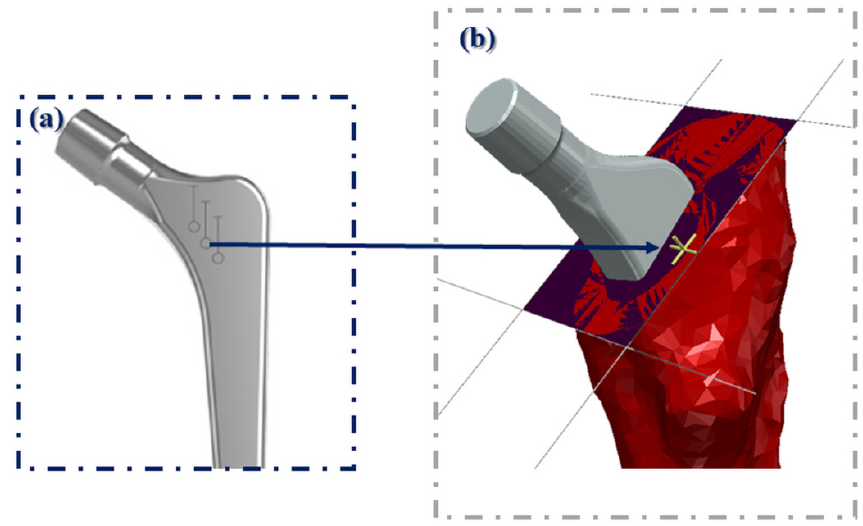
Figure 3. Schematic illustration of the point adopted for evaluation. ( a ) The middle depth marking of the femoral stem, ( b ) was translated to the posterior cortex of the proximal femur on the osteotomy plane.